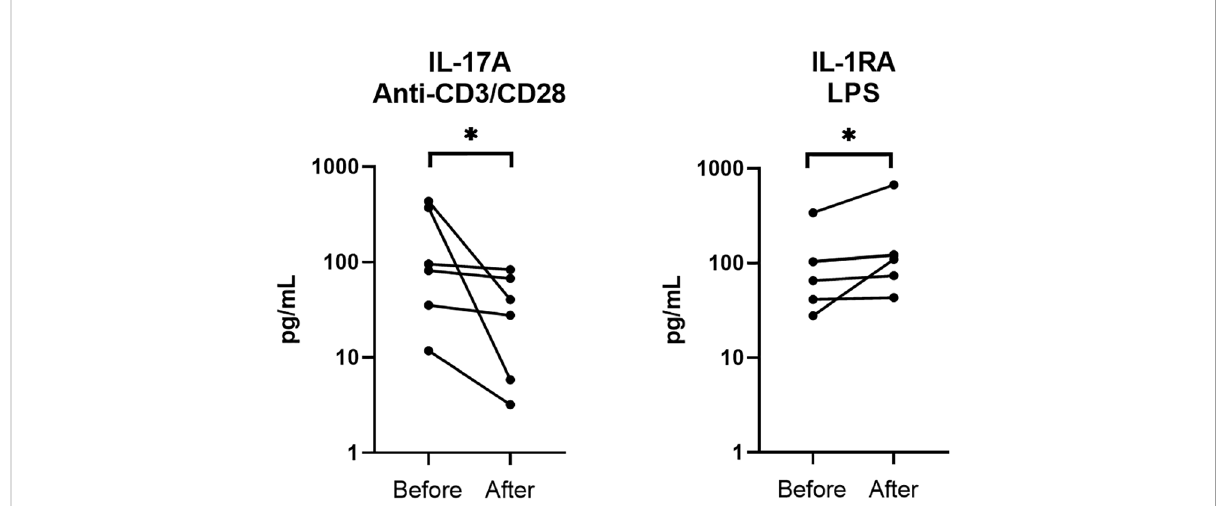
FIGURE 5 Comparison of ex vivo cytokine production in PsA patients before and after DMARD initiation (n = 6). PBMCs from 6 PsA patients were cultured at 1x10 6 cells/ml for 24 h at 37°C, 5% CO 2 with and without stimulation of monocytes by E. coli LPS (1 µg/mL) or T lymphocytes by anti-CD3/ CD28 mAb (2.5 × 10 4 beads/10 6 cells/ml). Supernatants were collected and cytokine levels were assayed by Luminex Multiplex ELISA. Difference between the groups using non-parametric Wilcoxon matched-pairs test is presented in the top of the fi gure for each condition. * p < 0.05. Each line represents a patient.